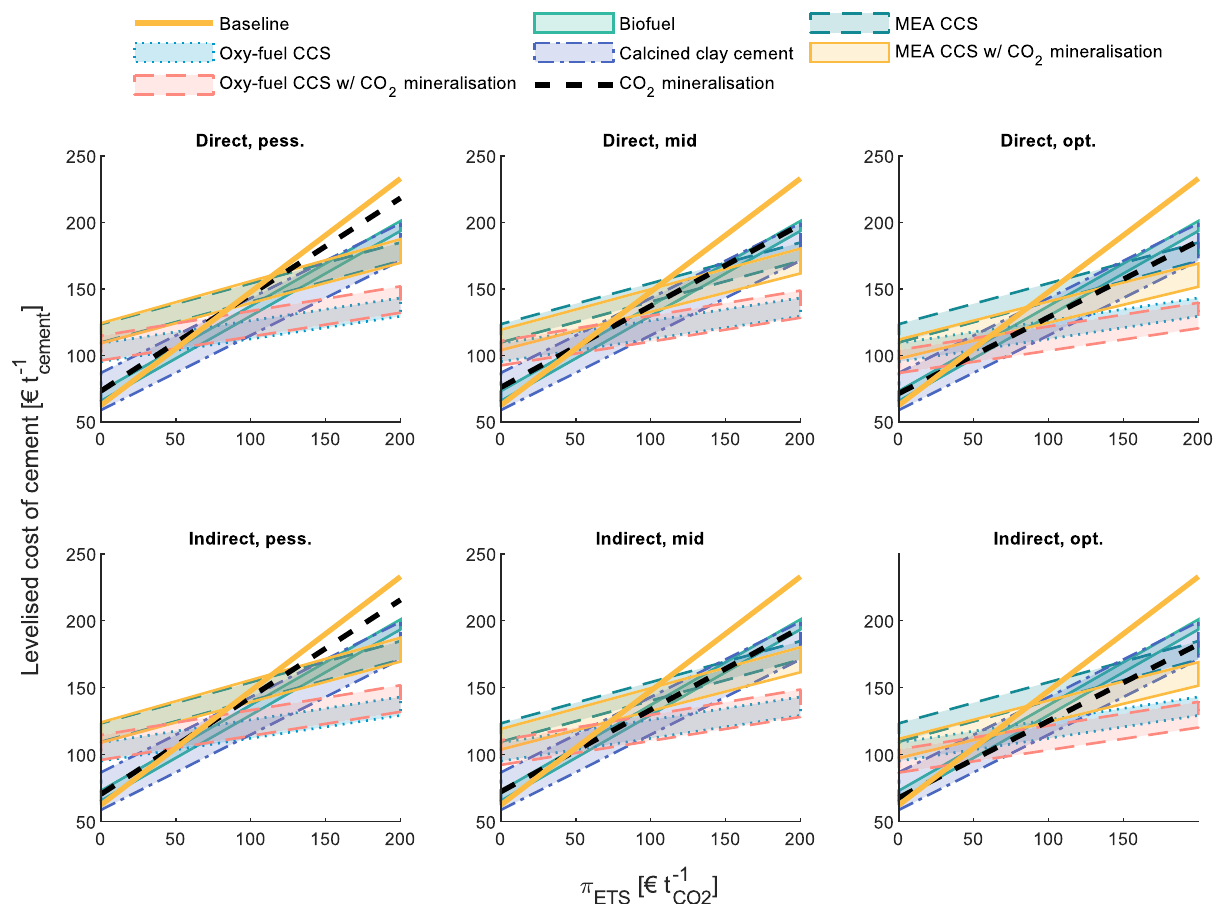
Fig. 6 Comparison of different emission reduction strategies under different ETS prices. Comparison of different emission reduction strategies: Baseline of conventional cement production (beige solid line), use of biofuel (light green area with solid borders), carbon capture and geological storage (CCS) with MEA postcombustion capture (dark green area with dashed borders), CCS with oxy-fuel combustion (blue area with dotted borders), calcined clay cement (violet area with dashed dotted borders), CCS with MEA post-combustion capture and CO 2 mineralisation (beige area with solid borders), CCS with oxy- fuel combustion and CO 2 mineralisation (red area with dashed borders) and CO 2 mineralisation (black dashed line). Transport assumptions: for CCS, transport 100 – 2000 km offshore pipeline; for calcined clay cement, 100 – 2000km transport of feed minerals; for CO 2 mineralisation the same assumptions are used as throughout this paper, 1200 km transport of feed minerals (Supplementary Table